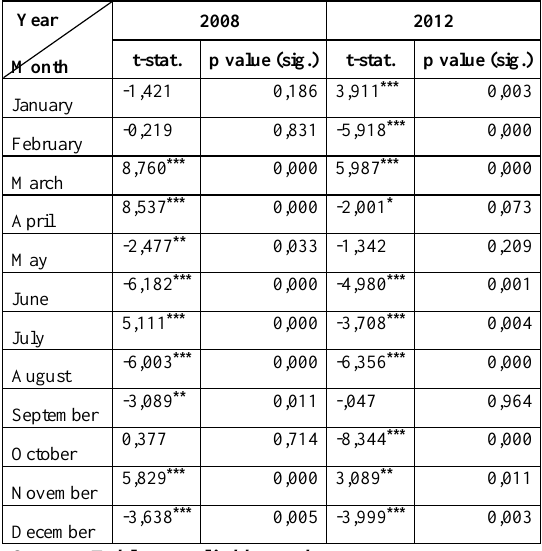
Table 4: t-statistics for CAR